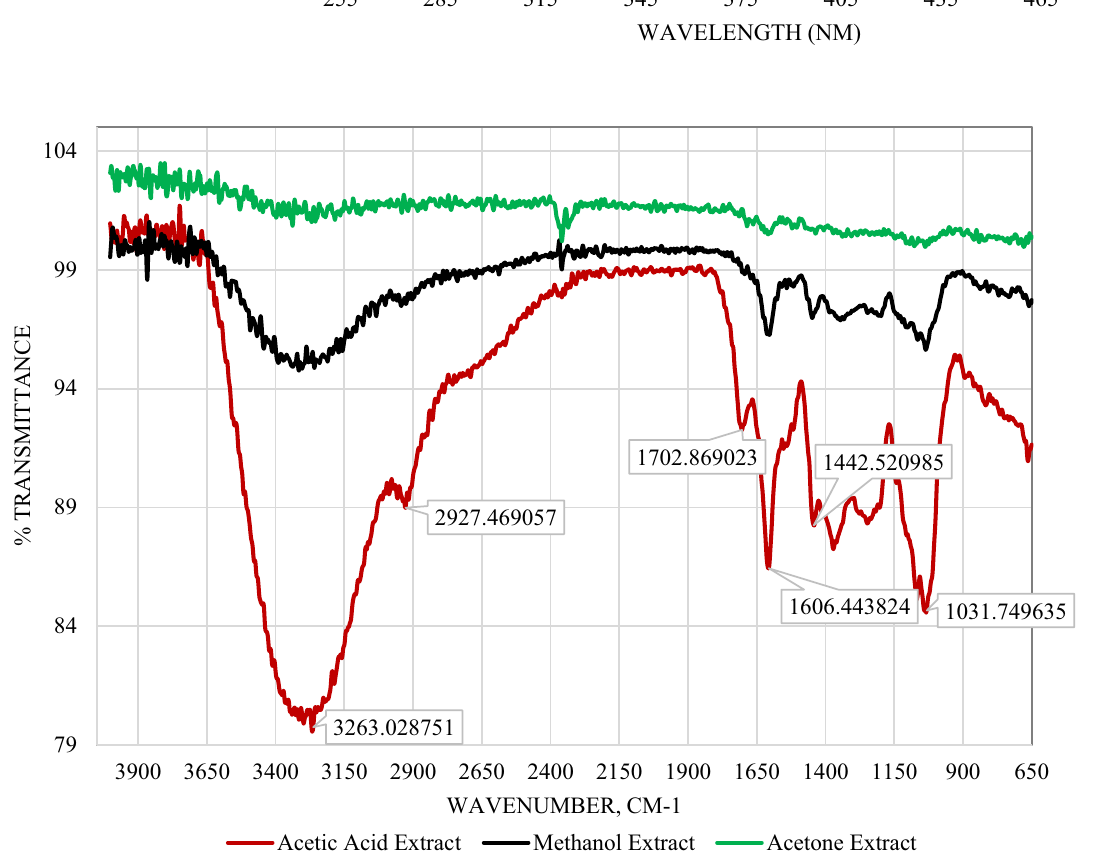
Fig. 4 Infrared spectra of Acacia rigidula extracts: acetone, methanol, and acetic acid. Peak values are given for distinct functional groups absorbed at their respective